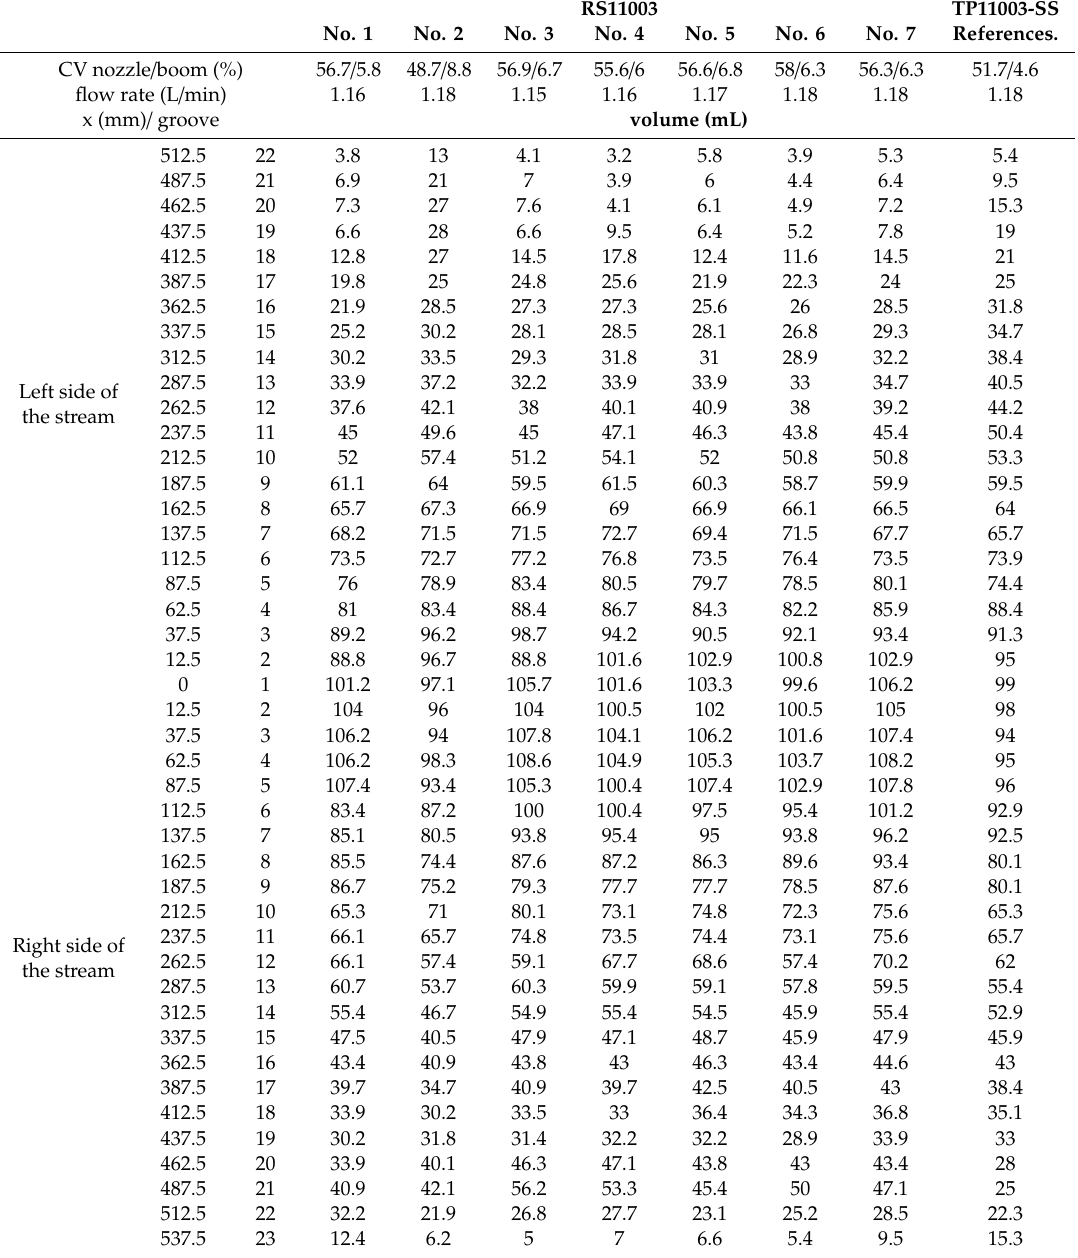
Table 2. Test results for RS11003 nozzles and TP11003-S reference